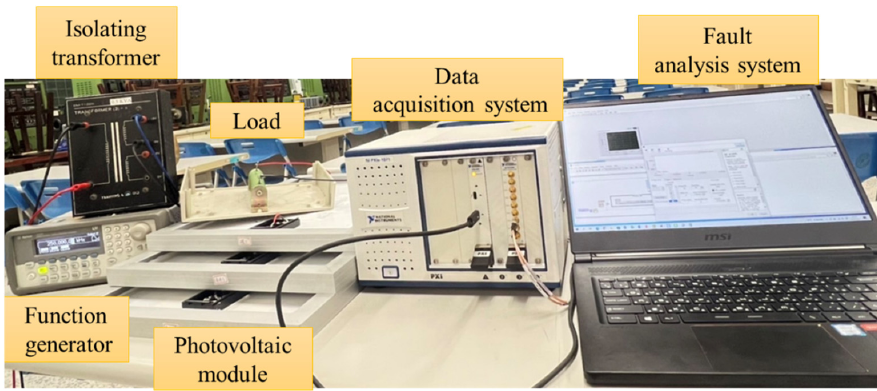
Figure 2. PV module fault detection testing platform.